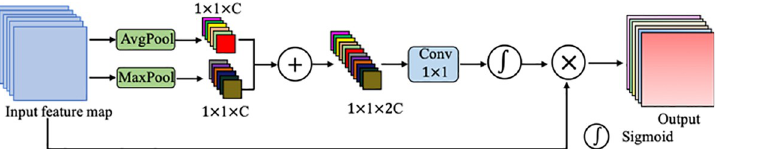
Fig 4. Diagram of the attention module. As illustrated, the attention module utilizes both max-pooling outputs and average-pooling outputs.